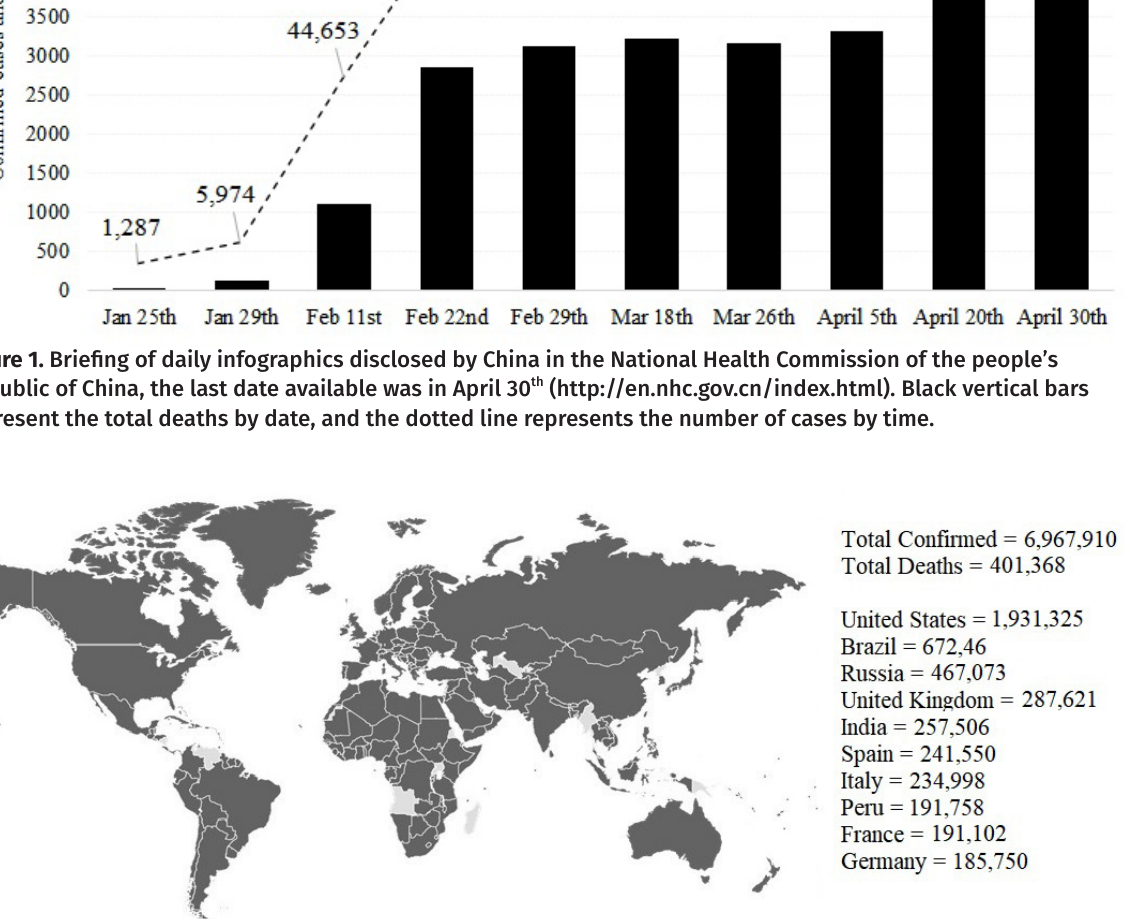
Figure 2. Total worldwide confirmed cases and the most 10 countries affected by COVID-19 (The map was captured from the CDC website and while the data are contained on the National Center for Immunization and Respiratory Diseases (NCIRD) and Johns Hopkins University websites). Data recovered in June 6 th , 7 p.m. Brazilia